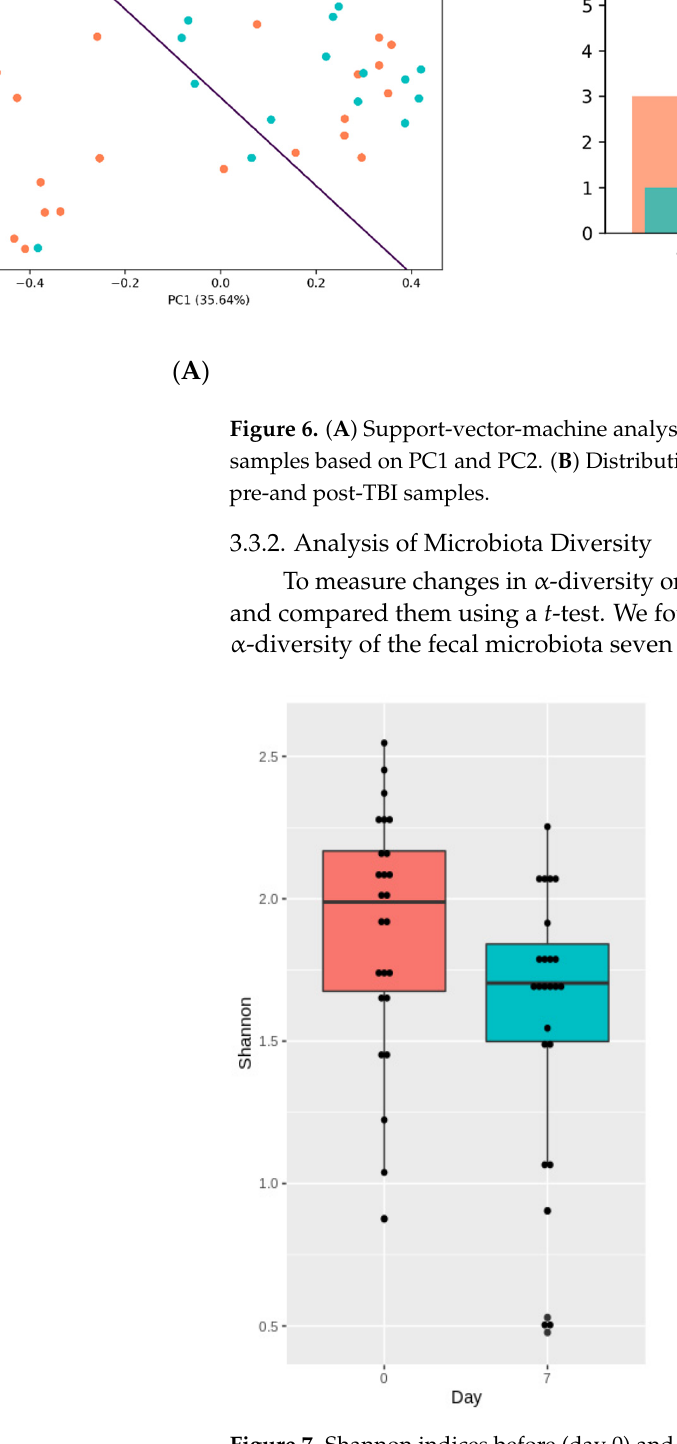
Figure 7. Shannon indices before (day 0) and after the TBI (day 7).